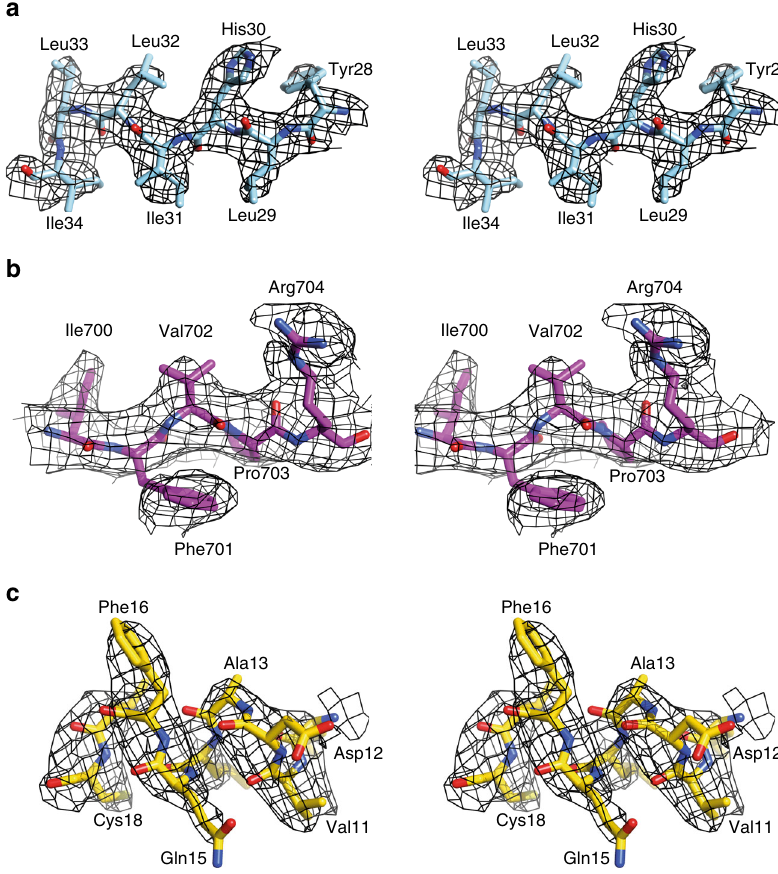
Fig. 2 Stereo view of representative σ A -weighted (2 F o − F c ) difference electron density. a The σ A -weighted (2 F o − F c ) difference electron density in the vicinity of IGF-1R Δβ L1 domain residues 28 – 34 within the crystal of apo IGF-1R Δβ + Fv 24 – 60. The density is sharpened ( B sharp = − 60 Å 2 ) and displayed at a contour level of 1.7 σ ( σ = root-mean-square deviation of the sharpened map). Density is shown only for volume within 2.0 Å of the atoms displayed. b The σ A -weighted (2 F o − F c ) difference electron density in the vicinity of IGF-1R Δβ α CT residues 700 – 704 within the crystal of apo IGF-1R Δβ + Fv 24 – 60. The density is sharpened ( B sharp = − 60 Å 2 ) and displayed at a contour level of 0.33 σ ( σ = root-mean-square deviation of the sharpened map). Density is shown only for volume within 2.5 Å of the atoms displayed. c σ A -weighted (2 F o − F c ) difference electron density in the vicinity of IGF-I residues 11 – 18 within the crystal of the IGF-I-complexed IGF-1R Δβ + Fv 24 – 60. The density is sharpened ( B sharp = − 60 Å 2 ) and displayed at a contour level of 1.7 σ (where σ is the root-mean-square deviation of the sharpened map). Density is shown only for volume within 2.0 Å of the atoms